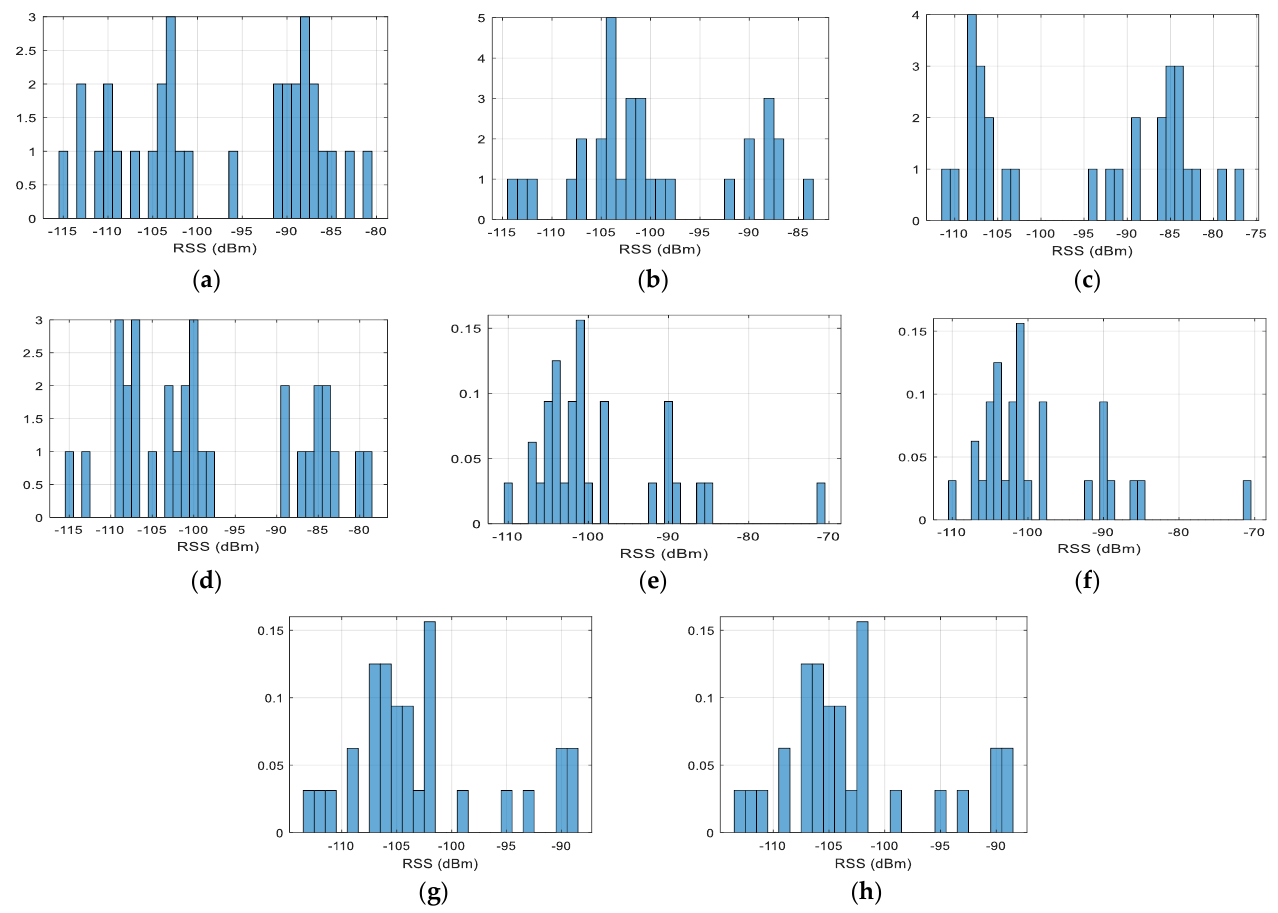
Figure 1. RSS Dataset distribution: ( a ) RSS observation 1, ( b ) RSS observation 2, ( c ) RSS observation 3, ( d ) RSS observation 4, ( e ) RSS observation 5, ( f ) RSS observation 6, ( g ) RSS observation 7, and ( h ) RSS observation 8.